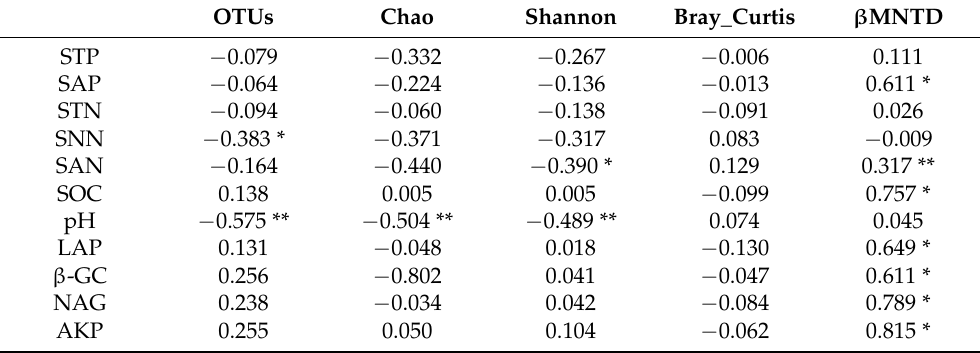
Table 2. Correlation analysis between indicators characterizing the structure of soil fungal communi- ties and soil chemical properties. OTUs Chao Shannon Bray_Curtis β MNTD STP − 0.079 − 0.332 −